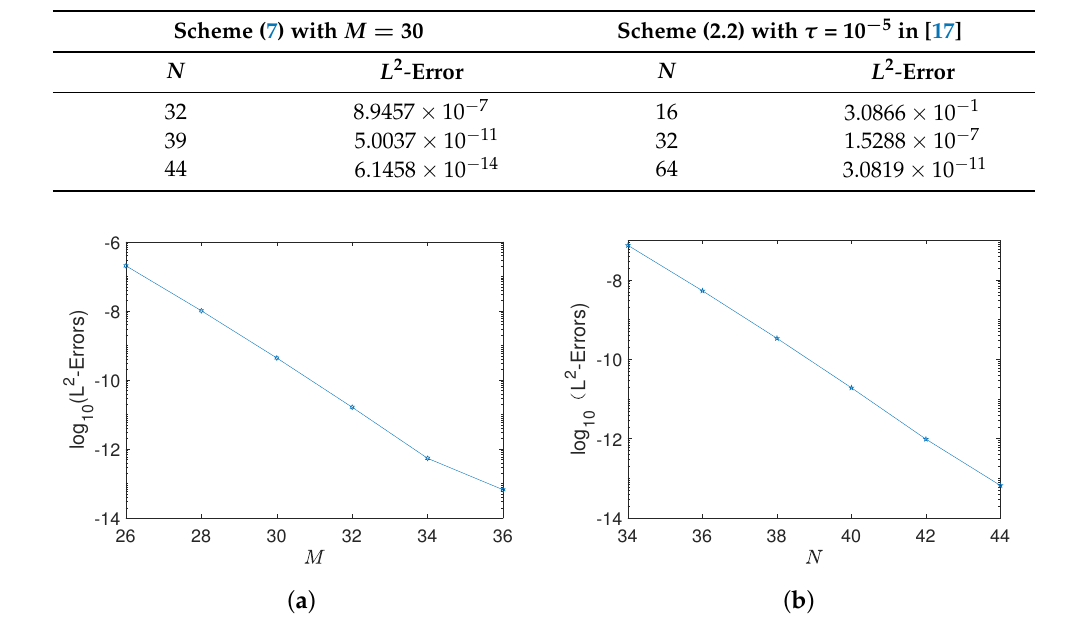
Table 2. Spatial errors at t = 1 for Example 1.